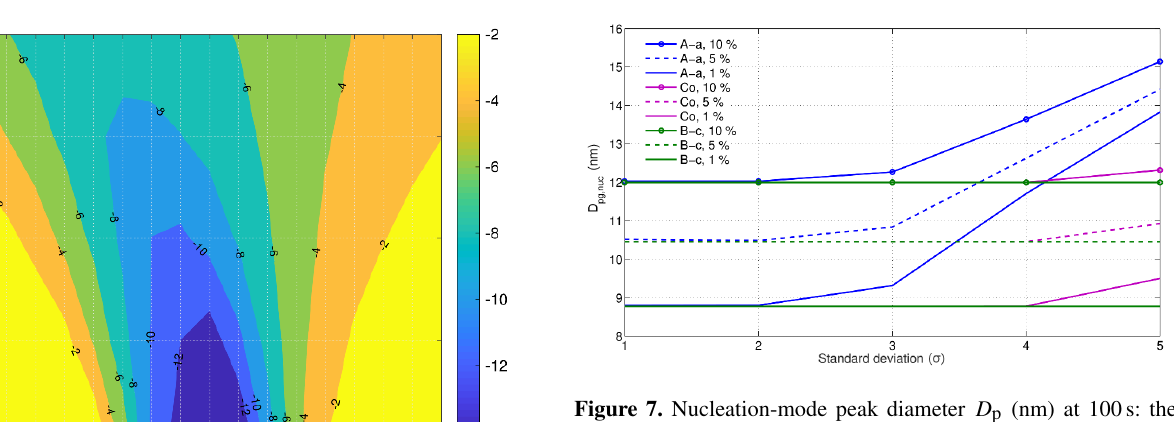
Figure 7. Nucleation-mode peak diameter D p (nm) at 100s: the “100s effective non-volatile core” for the nucleation mode. Results are shown at 1%, 5%, and 10% initial non- volatile material in the nucleation-mode particles, modal composition C 16 H 34 , and for various composition standard